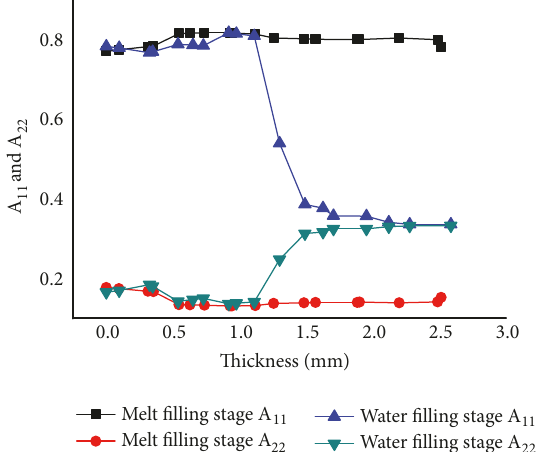
Figure 11: Interaction effect of melt temperature and delay time on A 22 .